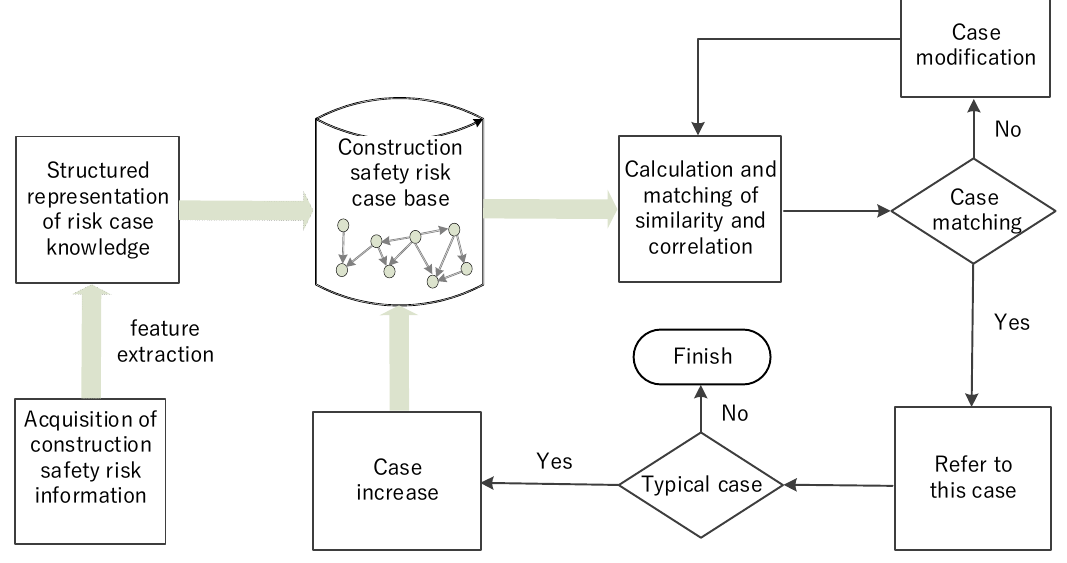
Figure 4. CBR framework for construction safety risks.